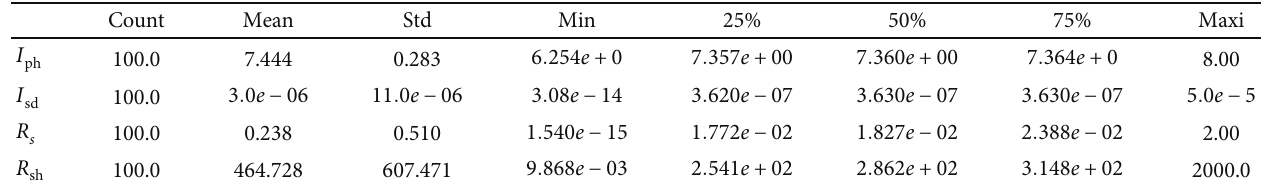
Figure 10: (a) Current-voltage characteristic of the di ff erent operations and the estimated curve in healthy operation. (b) Current-voltage characteristic of the di ff erent operations and the estimated curve for each Table 4: Statistical values of the training data.